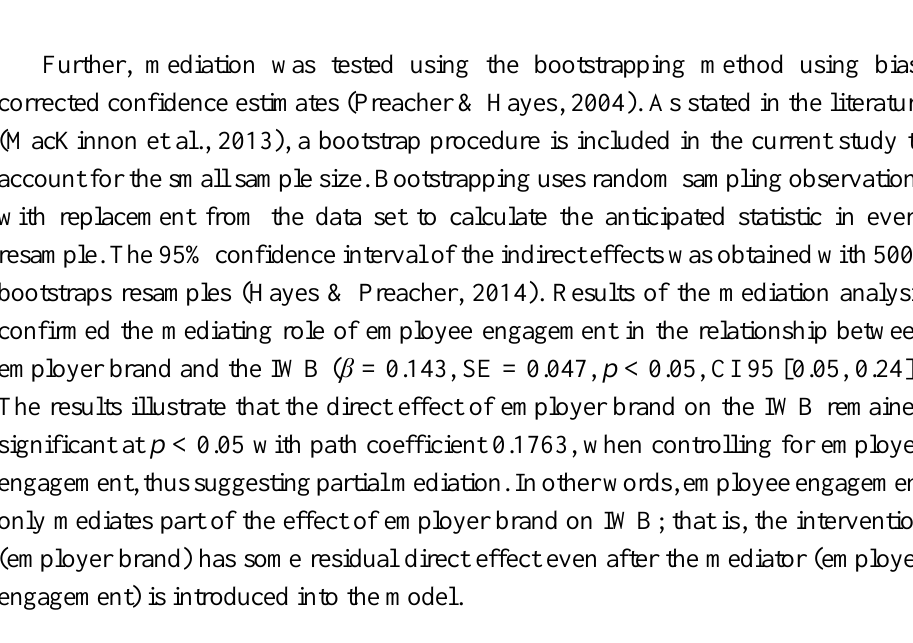
Table 2: The Direct, Indirect and Total Effects Path Direct Indirect Total EB→IWB